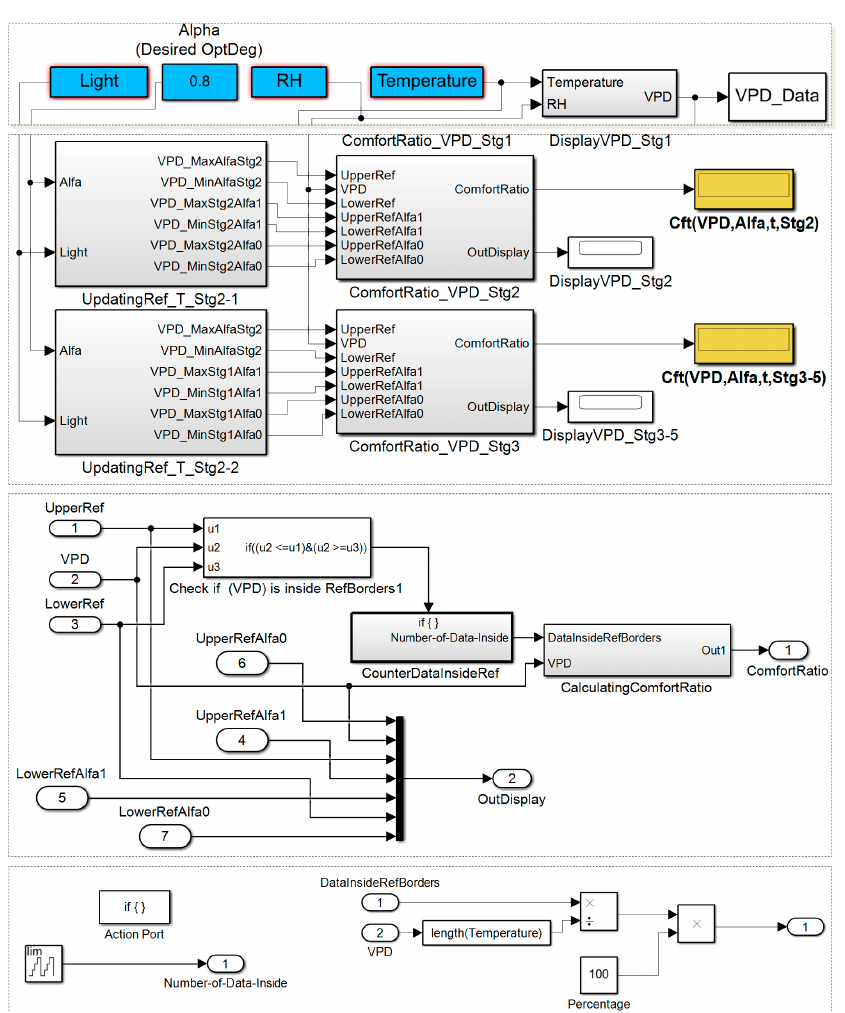
Figure 7. Implementation of the Cft-ratio model using Simulink blocks for validating the performance of the desiccant dehumidification Maisotsenko cycle evaporative cooling (M-DAC) system based on comfort ratios of vapor pressure deficit (VPD) for greenhouse production, reproduced from [56].